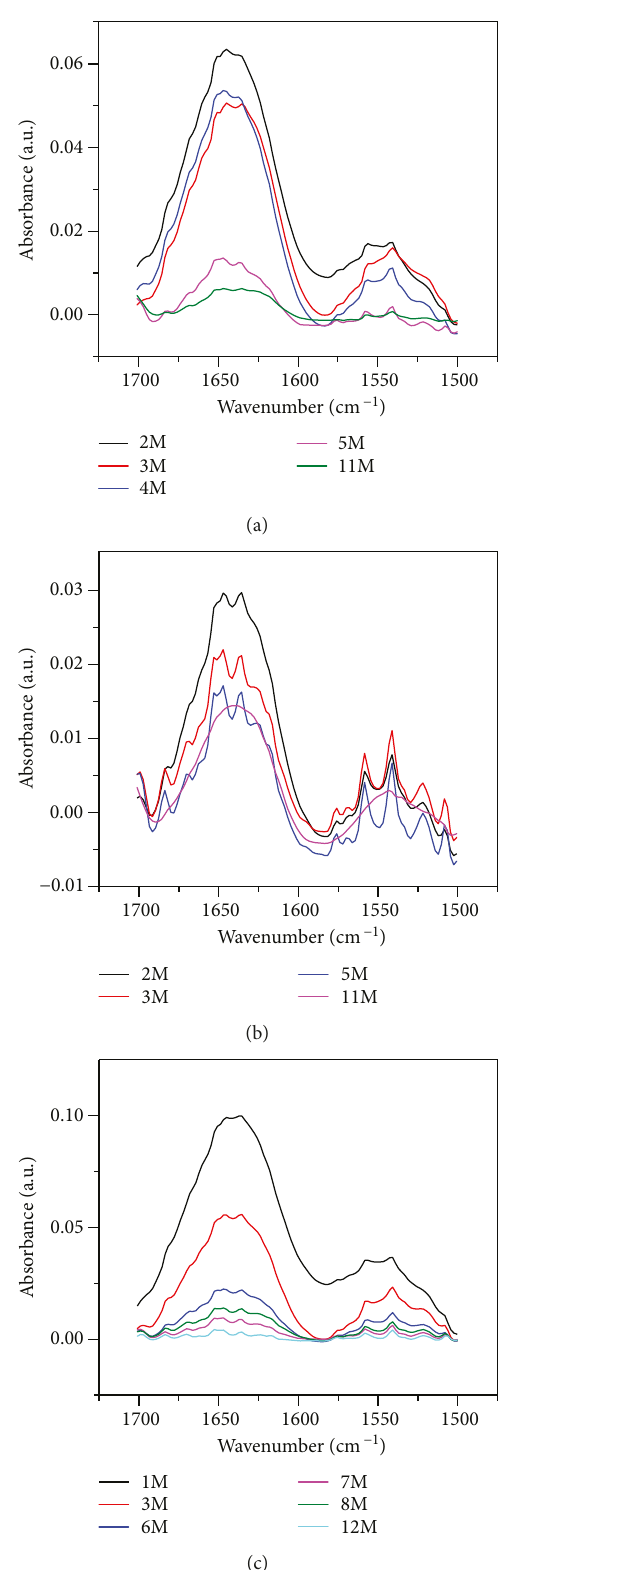
Figure 2: Fourier transform infrared spectra (1700 to 1500cm − 1 ) of Pecorino (a), Gouda (b), and ewes ’ ripe (c) cheese samples during ripening. M: months.